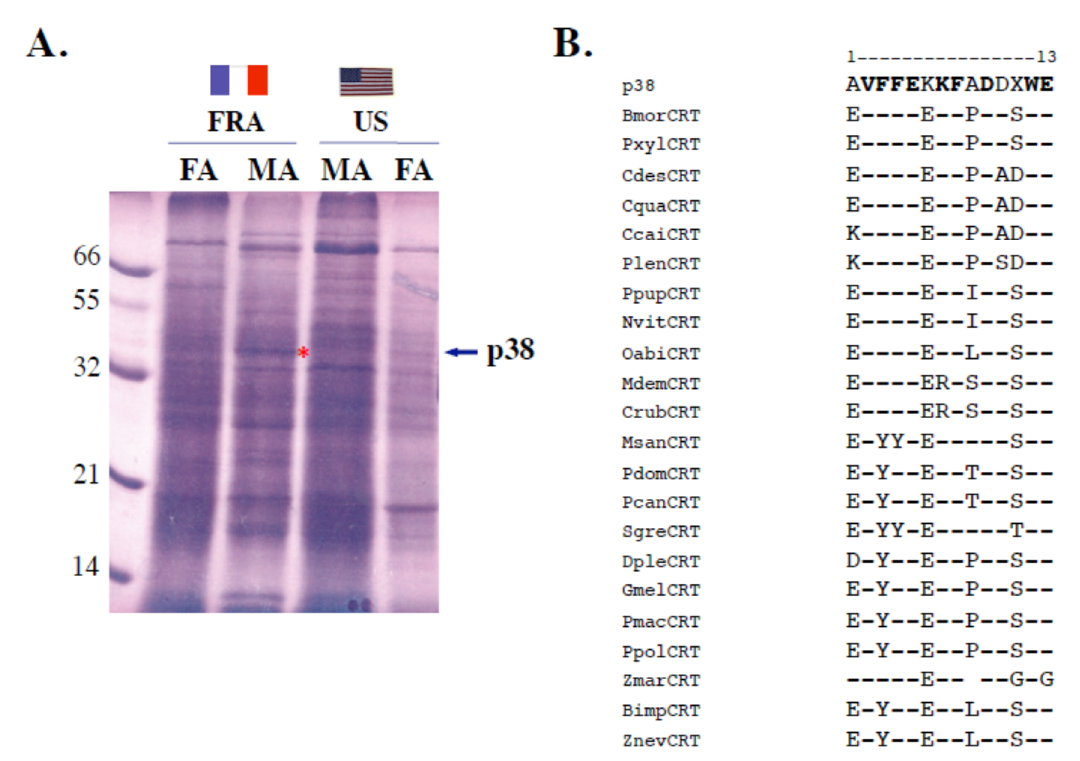
Figure 4. Identification of sex- and strain-specific calreticulin (p38) presence in A. ipsilon . ( A ) Electrophoretic comparison (15% SDS-PAGE) of antennal soluble protein extracts between the French and American A. ipsilon populations. MA: male antennae (40 eq.), FA: female antennae (40 eq.), FRA: French population, US: American population. The arrow indicates the position of a French population-specific soluble protein with an apparent molecular weight of 38 kDa (p38; see *). ( B ) Alignment of the N-terminal amino acid sequence of p38 (Edman degradation) with calreticulin (CRT) protein sequences from other insect species. Bmor: B. mori (BAC57964; NP_001037075),